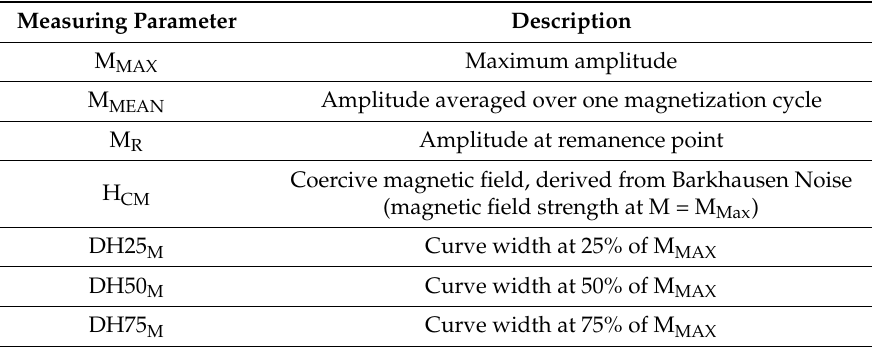
Table 3. Measuring parameters from Barkhausen Noise (BN).